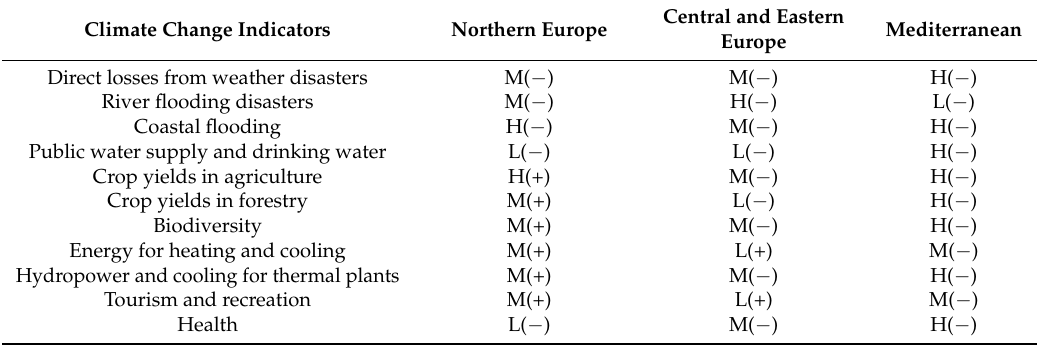
Table 1. Simplified summary of climate change impacts in Europe and their intensity. Climate Change